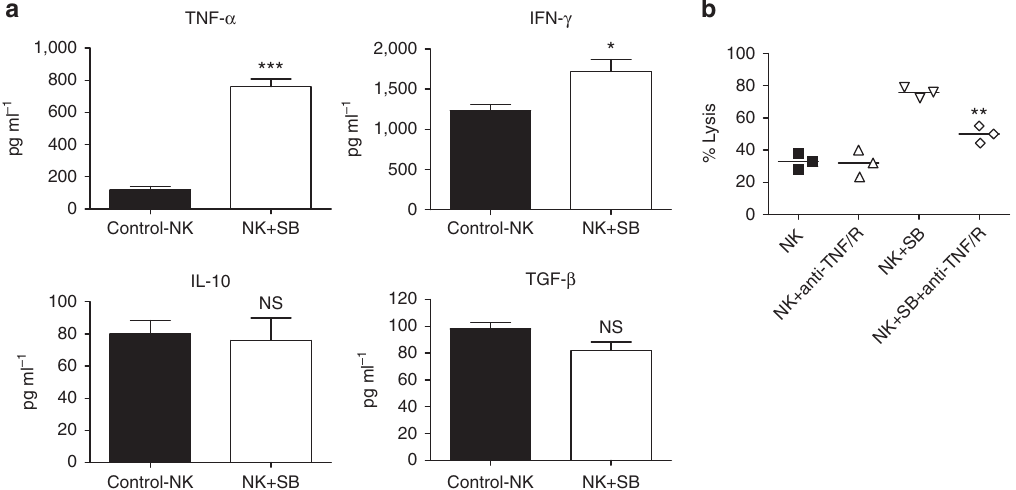
Figure 4 | GSK3 inhibition leads to NK cell hyperactivation partially in a TNF- a -dependent fashion. ( a ) Expanded NK cells were incubated with vehicle or SB for 16h, co-cultured with OCI-AML3 cells for 2h and then the indicated cytokine levels were measured in the conditioned medium by ELISA. ( b ) Expanded NK cells were treated with vehicle or SB for 16h, anti-TNF-receptor antibody (anti-TNF-R) and anti-TNF antibody (anti-TNF) were added to the indicated wells, the cells were co-cultured with OCI-AML3 cells and target cell lysis was measured using the calcein-AM assay. (unpaired Student’s t -test *** P o 0.001, ** P o 0.01, * P o 0.05, NS ¼ not significant P 4 0.05). Experiment is performed three